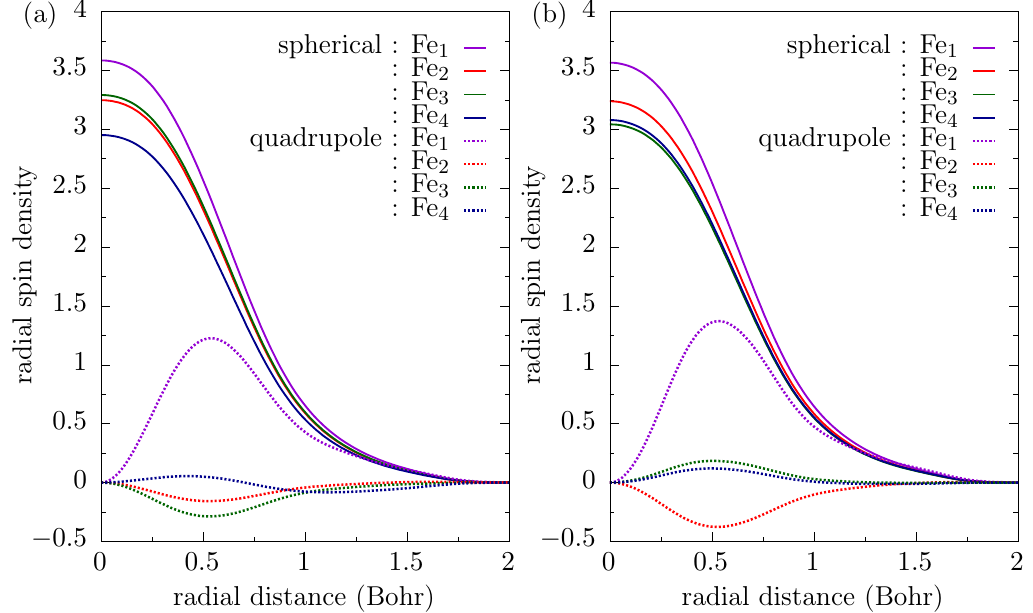
Figure 2. Radial atomic spin density distribution [in (Bohr) − 3 ] for ( a ) structure-I and ( b ) structure-II. All quadrupole components are magnified 20